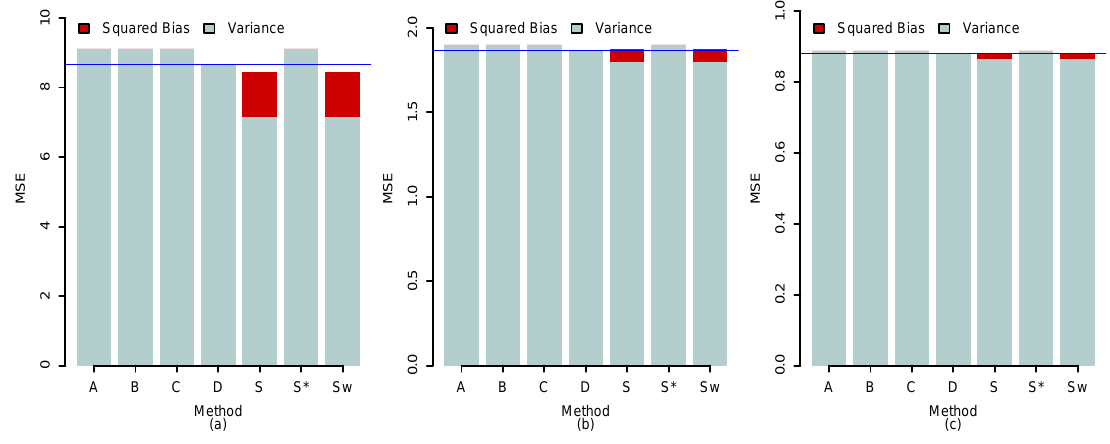
Figure 1. ( a ) n 1 = n 2 = n 3 = 3, ( b ) n 1 = n 2 = n 3 = 10, and ( c ) n 1 = n 2 = n 3 = 20.